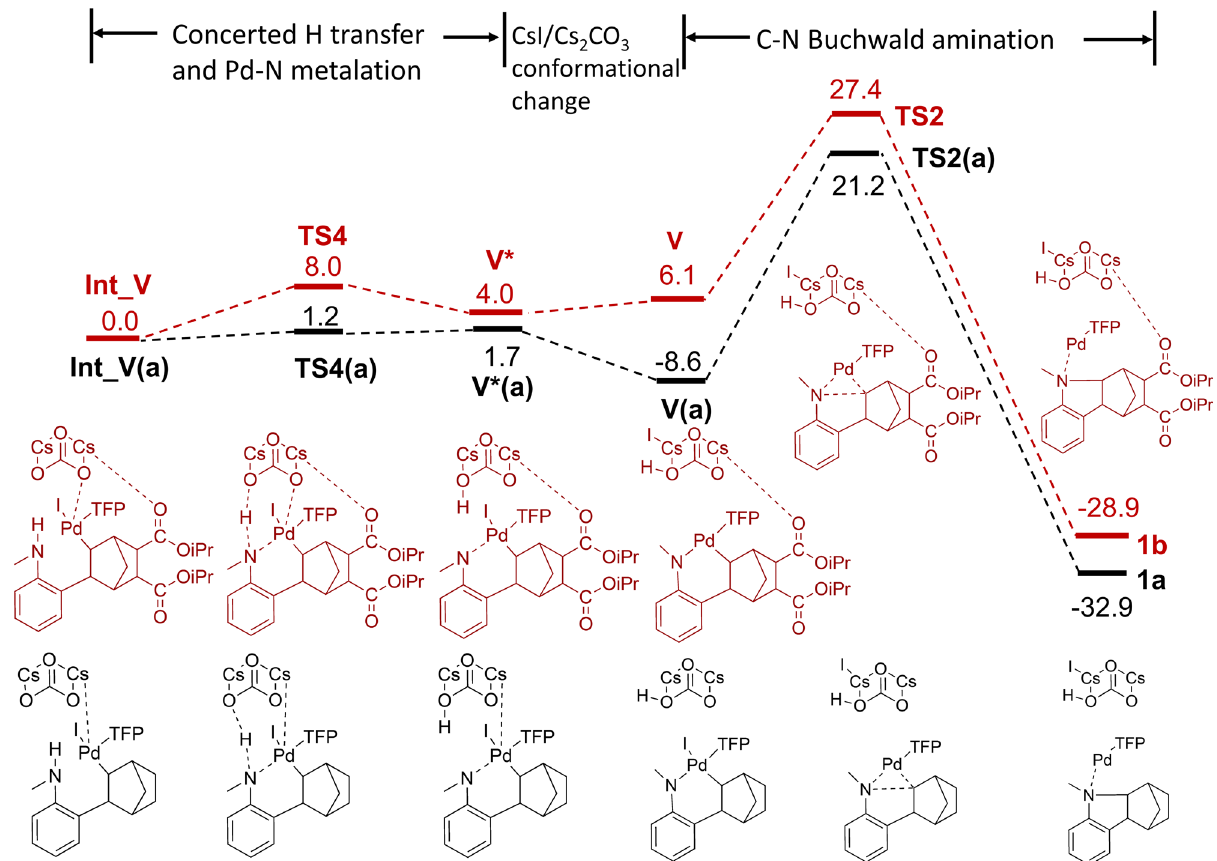
Fig. 8 Computed free energy pro fi le of Int_V → V → by-product 1a and 1b. Intermediates and transit states with 5,6-diCOO i Pr were illustrated in dark red, while unsubstituted ones were illustrated in black. The energies are given in